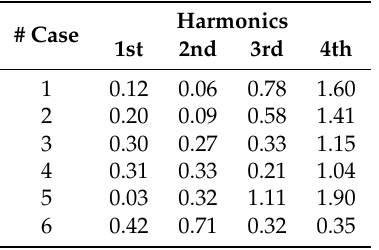
Table 3. Phase Angles Error in Degrees for Generation Test